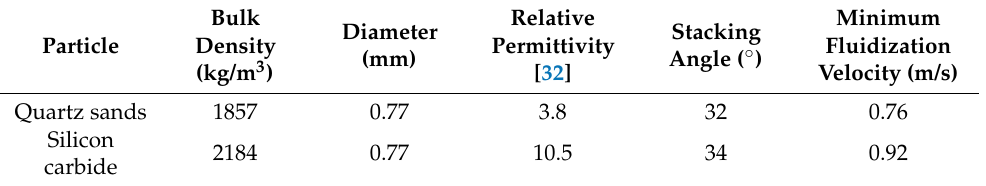
Table 1. Physical properties of particle